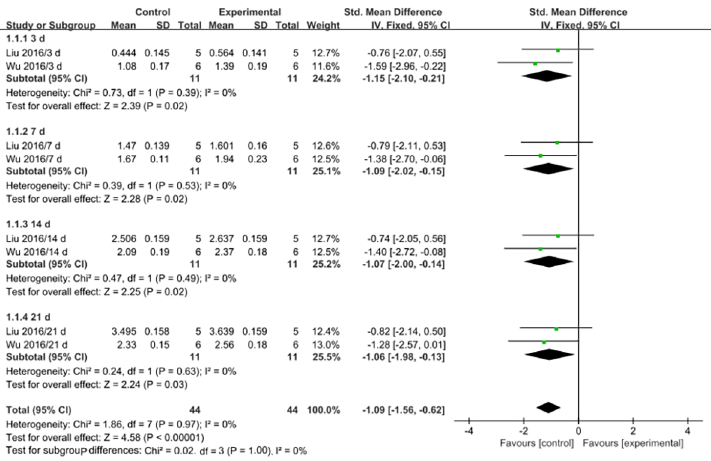
Fig 4. Forest plots showing the effects of MSCs on GSH levels. Control: PQ group; Experimental: MSC treatment group; CI: confidence interval; IV: independent variable; SD: standard deviation.